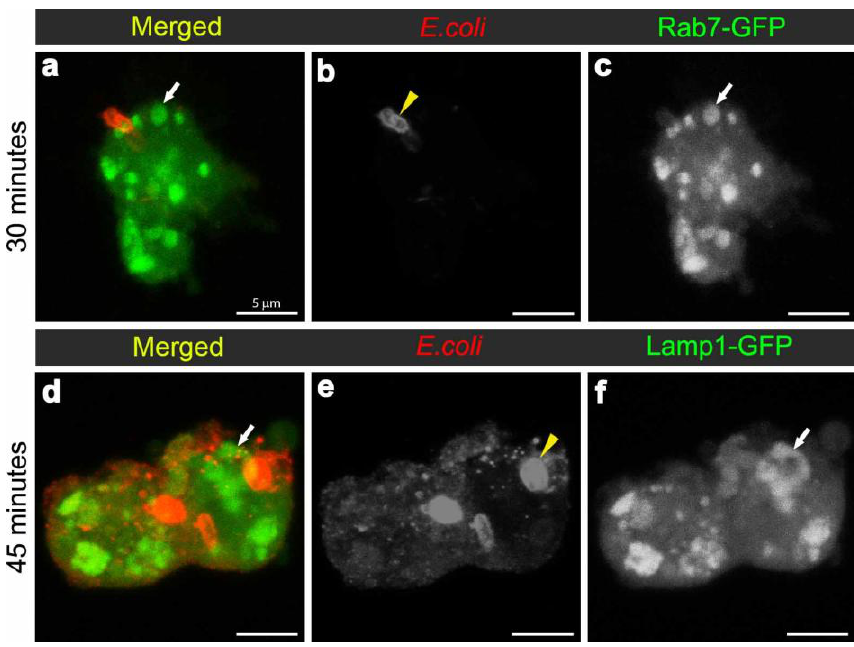
Figure 6. Confocal micrographs depicting hemocytes isolated from the 14-3-3 (cid:72) protein null mutant female flies at 30 minutes (a-c) and 45 minutes (d-f) after infection with E. coli (red in a, d and grayscale in b, e ). Confocal micrographs also show Rab7-GFP-positive vesicles (green in a ; grayscale in c ) and Lamp1-GFP positive vesicles (green in d ; and grayscale in f ) and depicted by arrows. Scale bars = 5µm as labeled in (a)